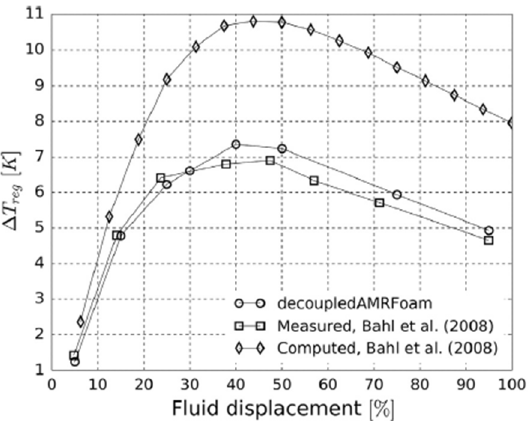
Figure 39. Results obtained for a set of operating conditions to visualize the ( a ) velocity field and ( b ) the temperature field during the solid regeneration after magnetization in a portion of the porous regenerator [60].